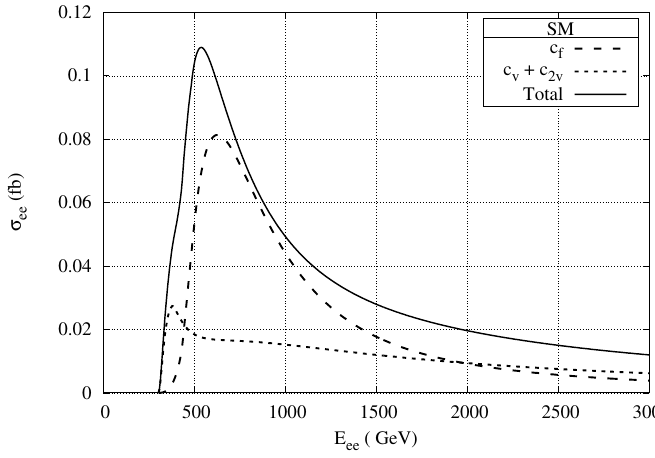
Figure 2 . Production cross-section ( e + e − → hh ) in the SM. The contributions labeled c f and c v + c 2 v refer to the individual contributions of tops and gauge bosons respectively (cf. table